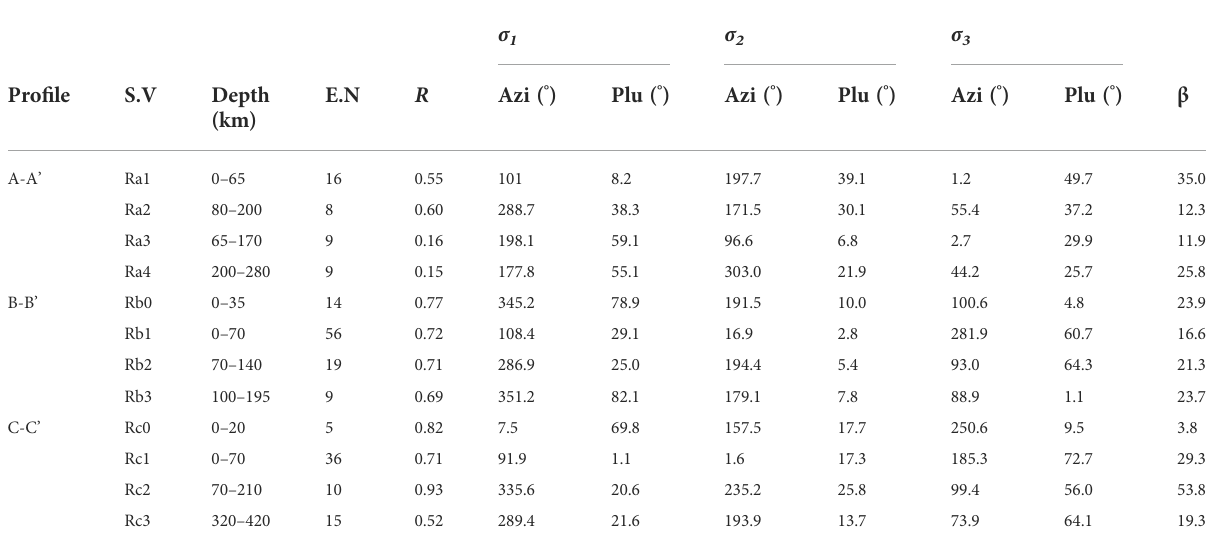
TABLE 3 Results of the stress